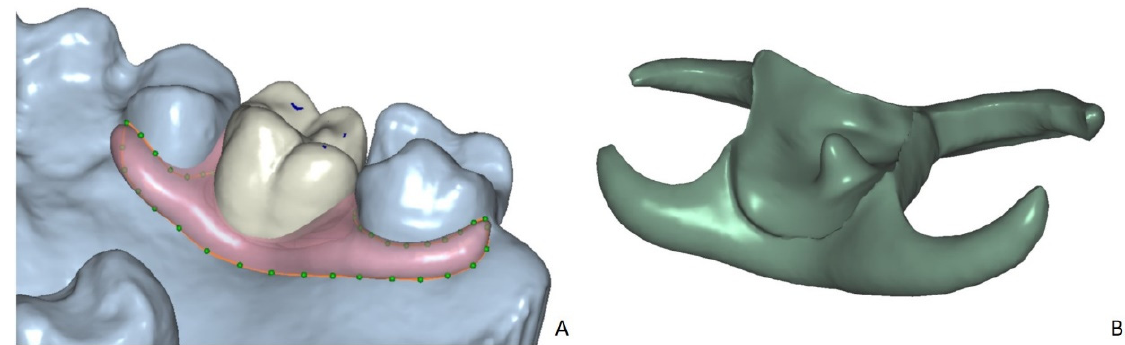
Figure 2. ( A ) The virtual design of the denture base in the CAD software (Dental CAD, Exocad, Darmstadt, Germany) with the applied pontic tooth, using the “attachment” function. ( B ) The final denture design with a corresponding reten- tion socket for the pontic tooth.